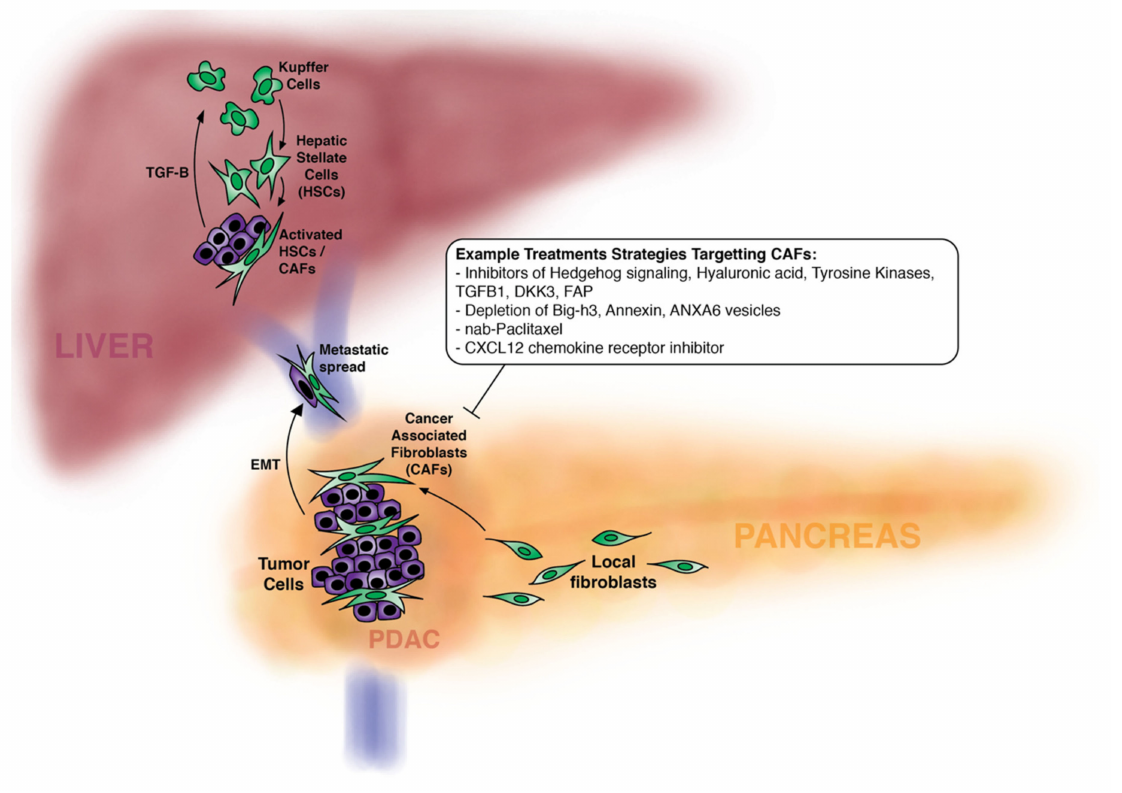
Figure 2. Primary pancreatic cancer recruits fibroblasts to become cancer associated fibroblasts (CAFs). Tumor cells with CAFs invade the portal vein and metastasize to the liver. In order to establish a focus in the liver, Kup ff er cells secrete transforming growth factor-beta (TGF-beta) that recruits and activates hepatic stellate cells to become CAFs. Strategies to treat pancreatic cancer through CAFs include inhibitors of the hedgehog pathway, hyaluronidase, tyrosine kinase, and inhibitors of CAF recruitment. miRNAs are a potentially useful strategy because such tools can inhibit multiple pathways, simultaneously. Nab-Paclitaxel has been shown to target pancreatic cancer CAFs. AMD3100, a CXCL12 chemokine receptor inhibitor, shows improved immune response / immunotherapy response to pancreatic cancer—CXCL12 is secreted by